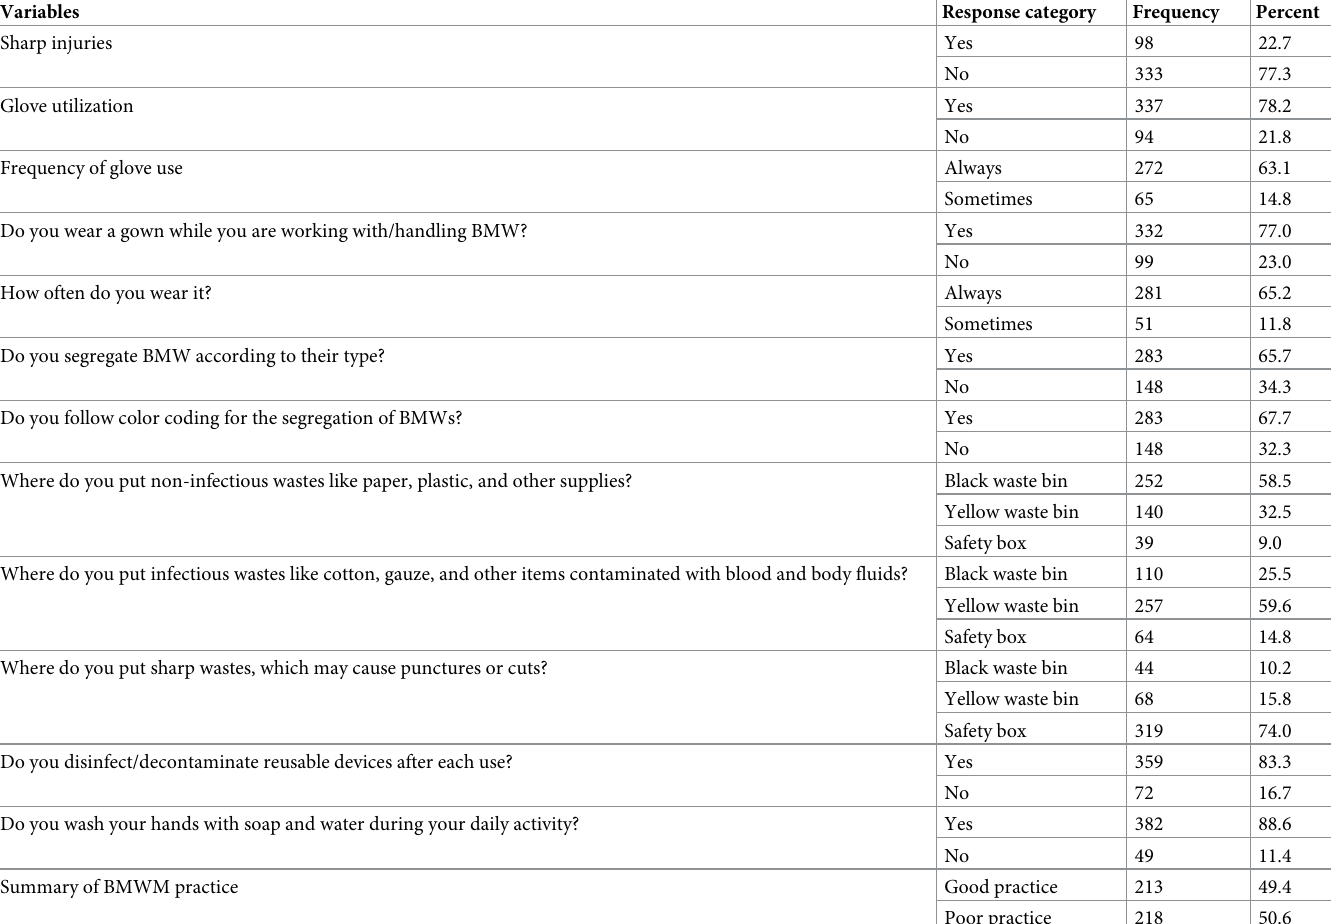
Table 5. Practice of health care workers among each practice item question at metropolitan cities private hospitals of Amhara region, Ethiopia, December